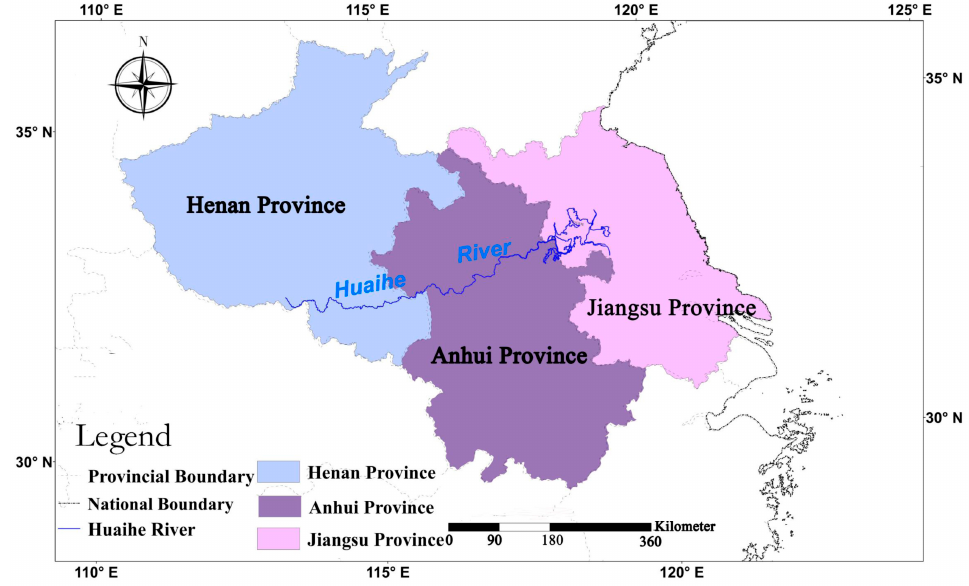
Figure 1. The spatial distribution and location of the associate province of Huaihe River basin.